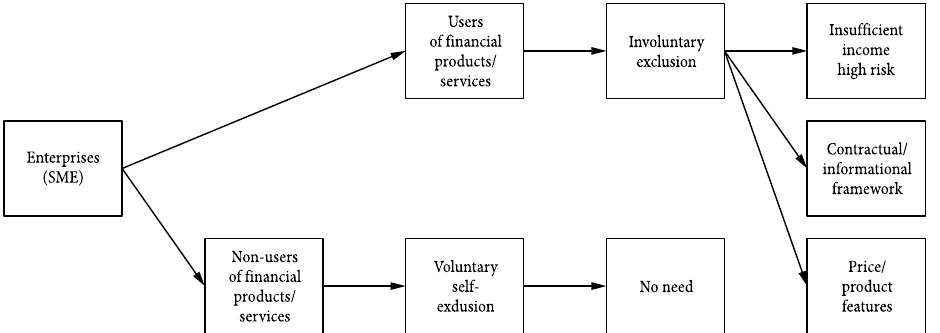
Fig. 1. The difference between the access to finance and the use of financial products/services Source: based on Demirguc-Kunt et al. (2008: